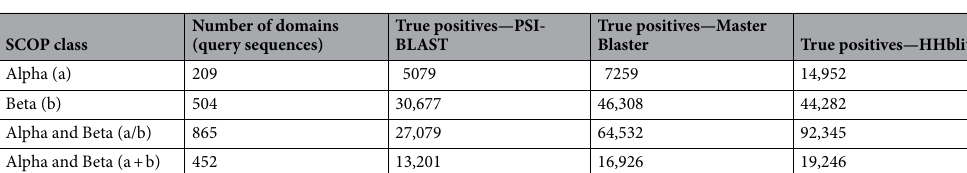
Table 5. Number of domains considered as queries from different structural classes of SCOP and the number of true positives reported using PSI-BLAST, Master Blaster and